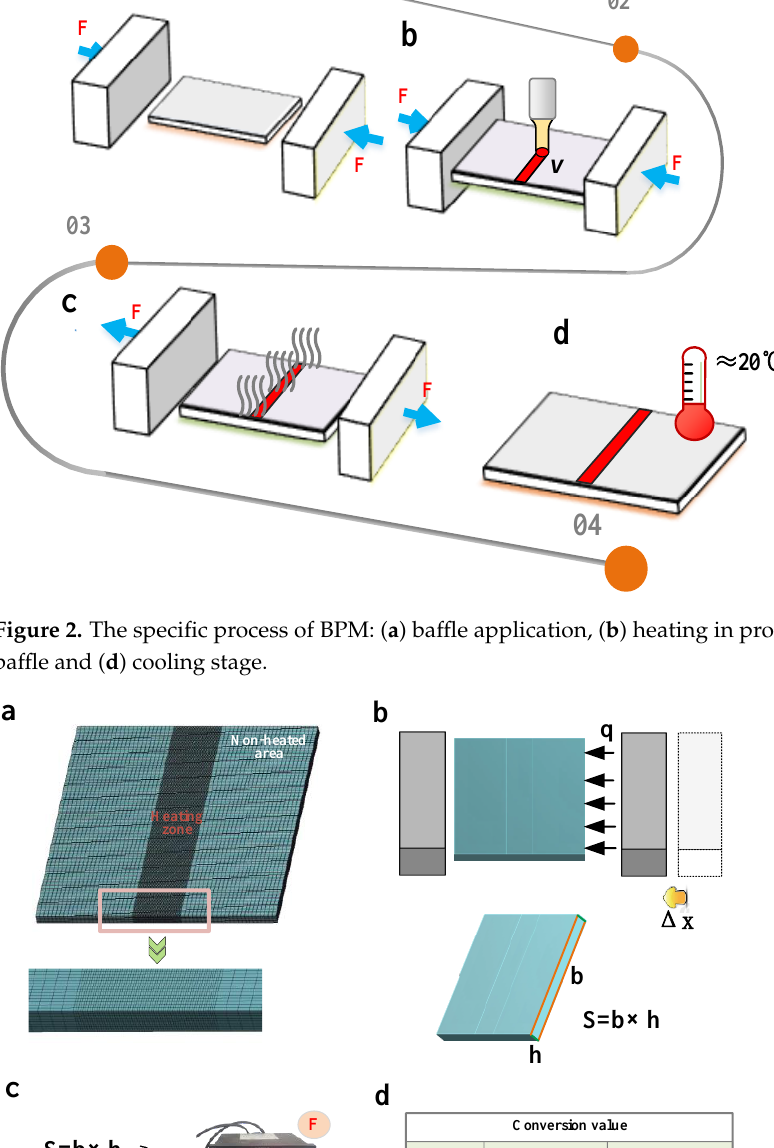
Figure 4. Thermophysical parameters at different temperatures. The selected parameters are presented in Table 1.